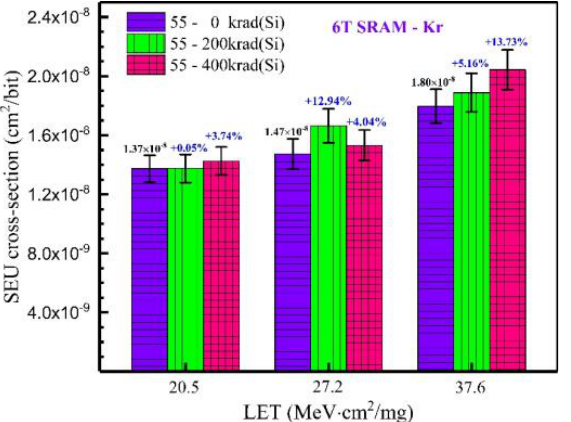
Figure 4. SEU cross-sections versus LET for 6T SRAMs. The purple horizontal column represents data for TID = 0 rad(Si), the green vertical column represents data for TID = 200 krad(Si), and the pink checkerboard represents data for TID = 400 krad(Si).